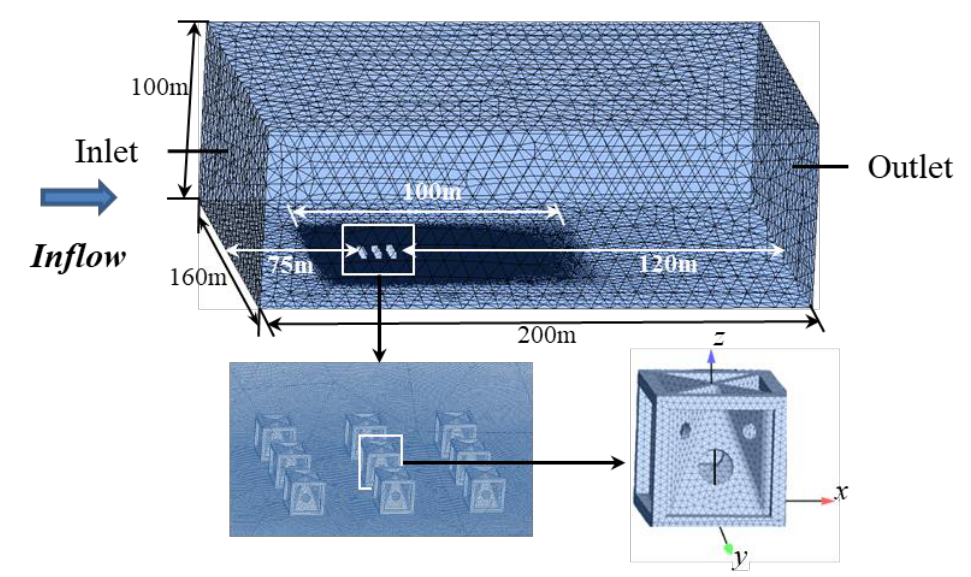
Figure 3. Computational domain and the grid division.